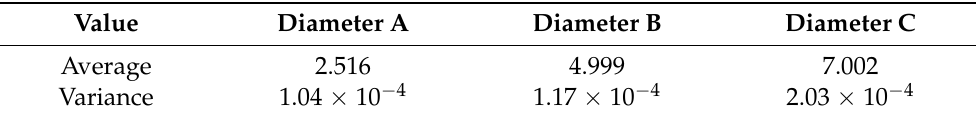
Table 5. Descriptive statistics.